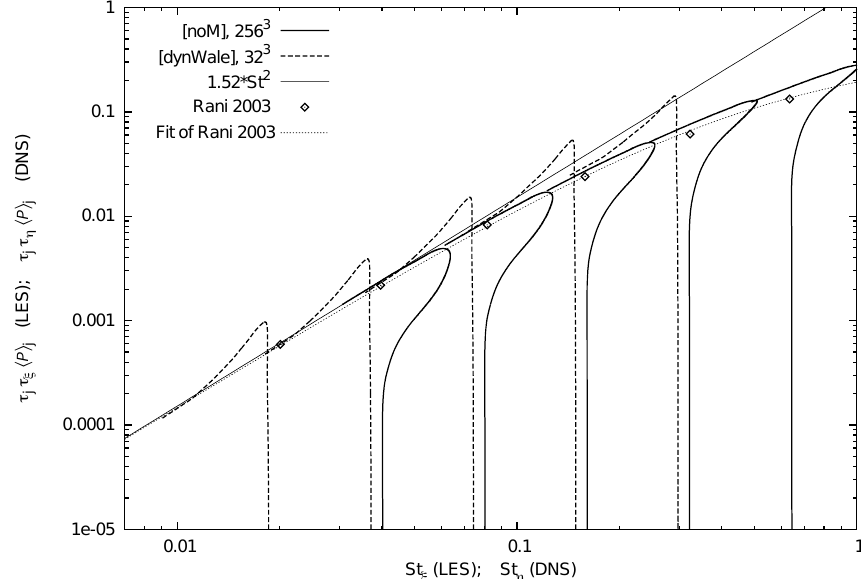
Figure 7. Evolution of the degree of preferential concentration with St ξ (LES) or St η (DNS). We obtain a good agreement between equilibrium–Eulerian LES/DNS and Lagrangian DNS simulations. The fit for the data by Rani and Balachandar (2003) is found in Eq.